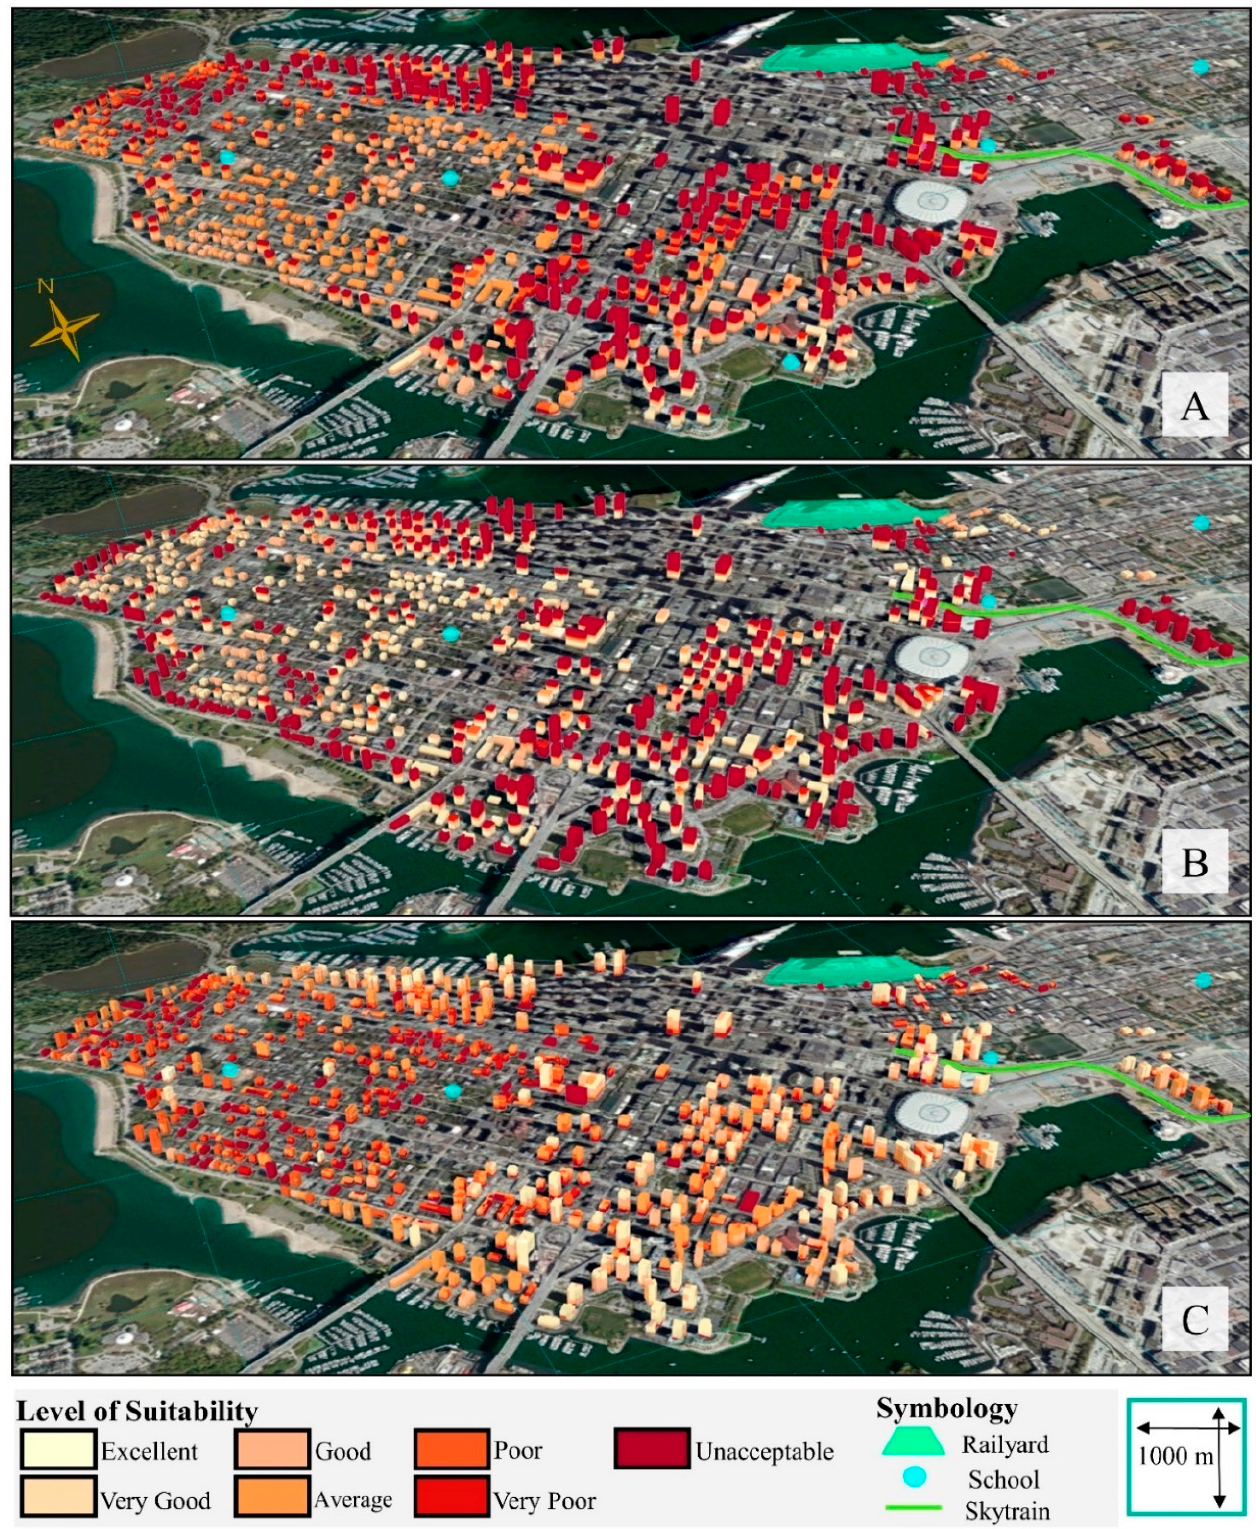
Figure 5. Results of the 3D LSP multicriteria evaluation (MCE) suitability analysis for Scenarios ( A ) 1, ( B ) 2, and ( C ) 3.